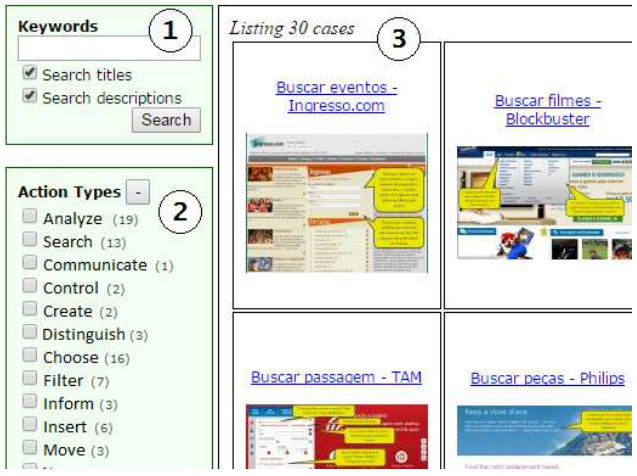
Fig. 2. CHIDeK's main page, cropped.